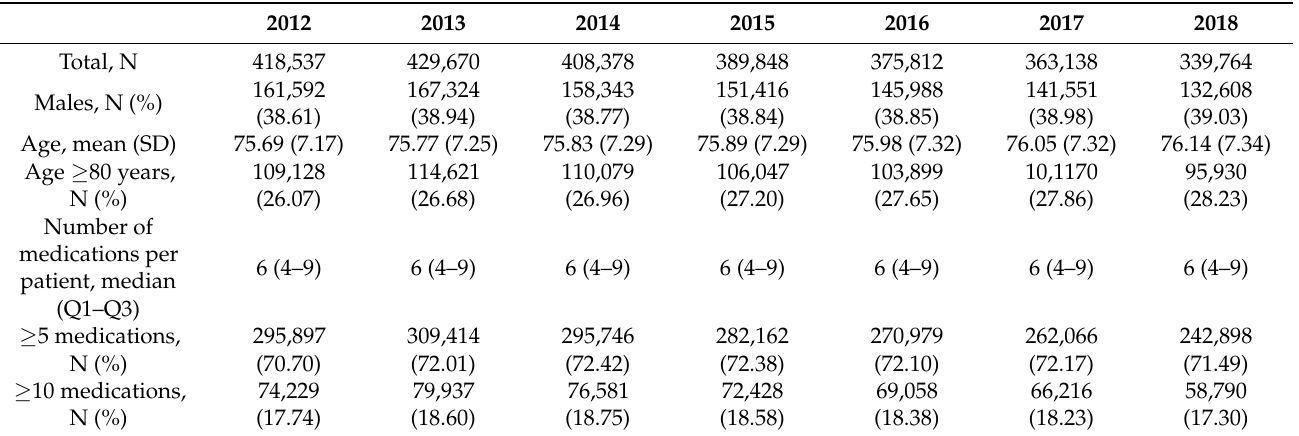
Table 1. Characteristics of outpatients older than 65 years exposed to at least one potentially inappro- priate prescription in Piedmont in the period 2012–2018.